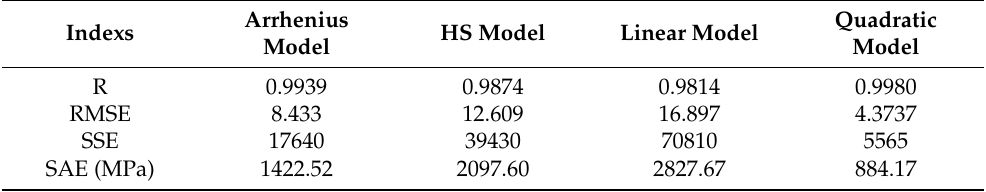
Table 7. Quantitative comparison of predictability of different models.